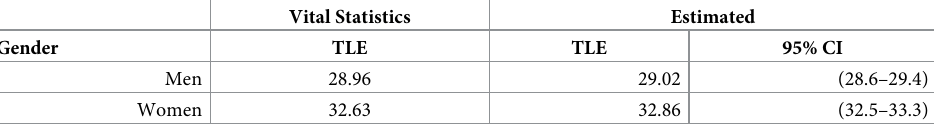
Note . The vital statistics are from the life table in 2006 from Tables 2 and 3 of Arias (2010) [51] with tables updated using revised intercensal populations. TLE = total life expectancy. 95% CI = 95% confidence interval. Data from Health and Retirement Study.